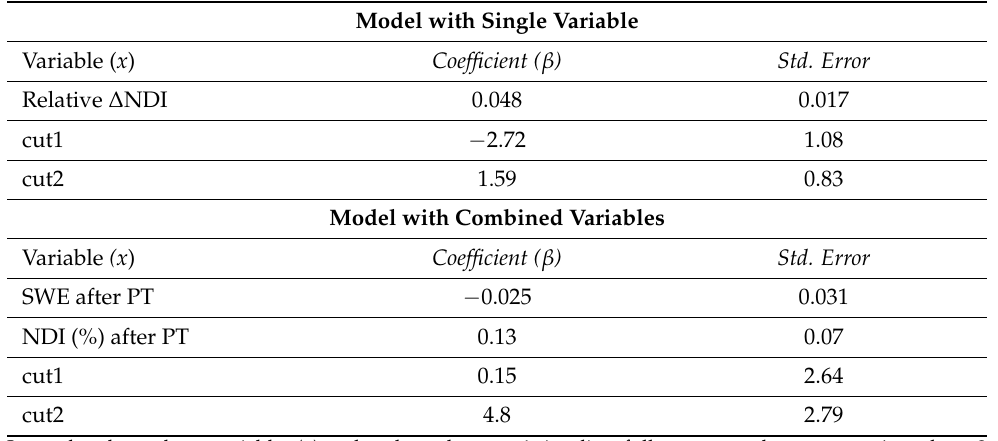
Table 5. Model coefficients for most accurate